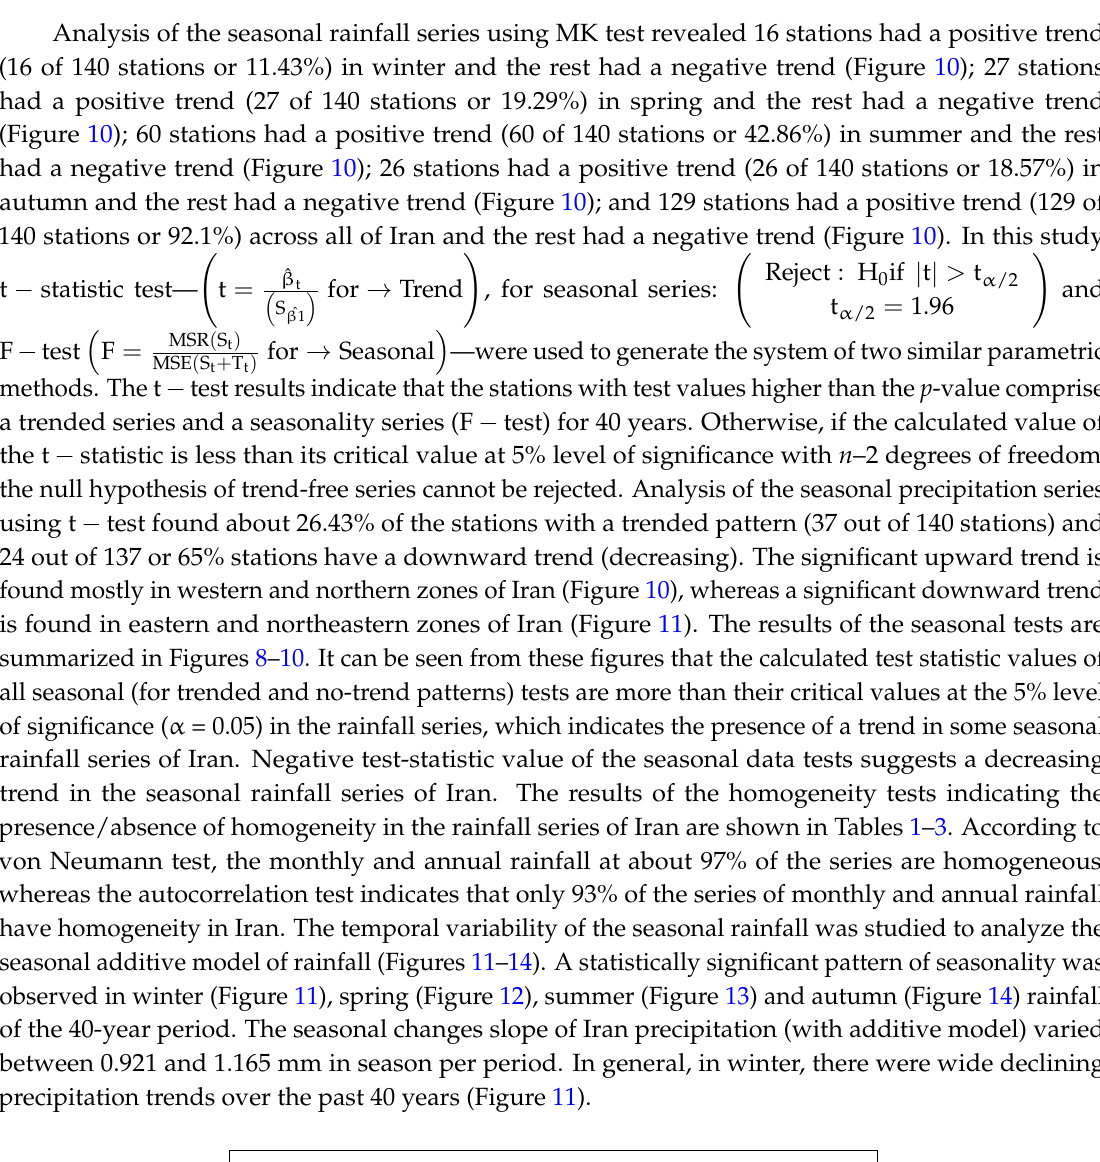
Figure 12. Forecast of spring rainfall variations (seasonal additive model).